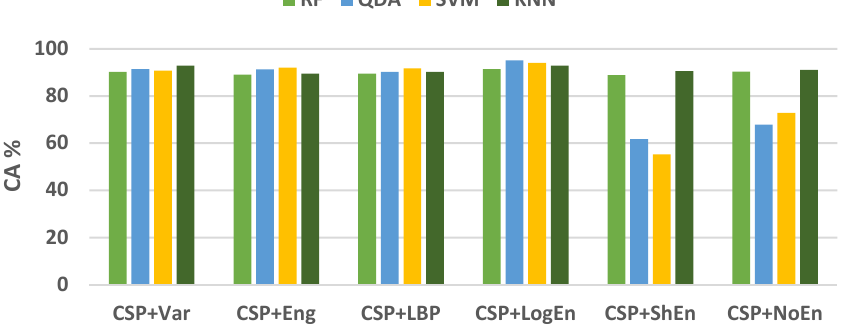
Figure 9. Average classification accuracy (on–PD vs. HC) using LDA, SVM, KNN, and LR.